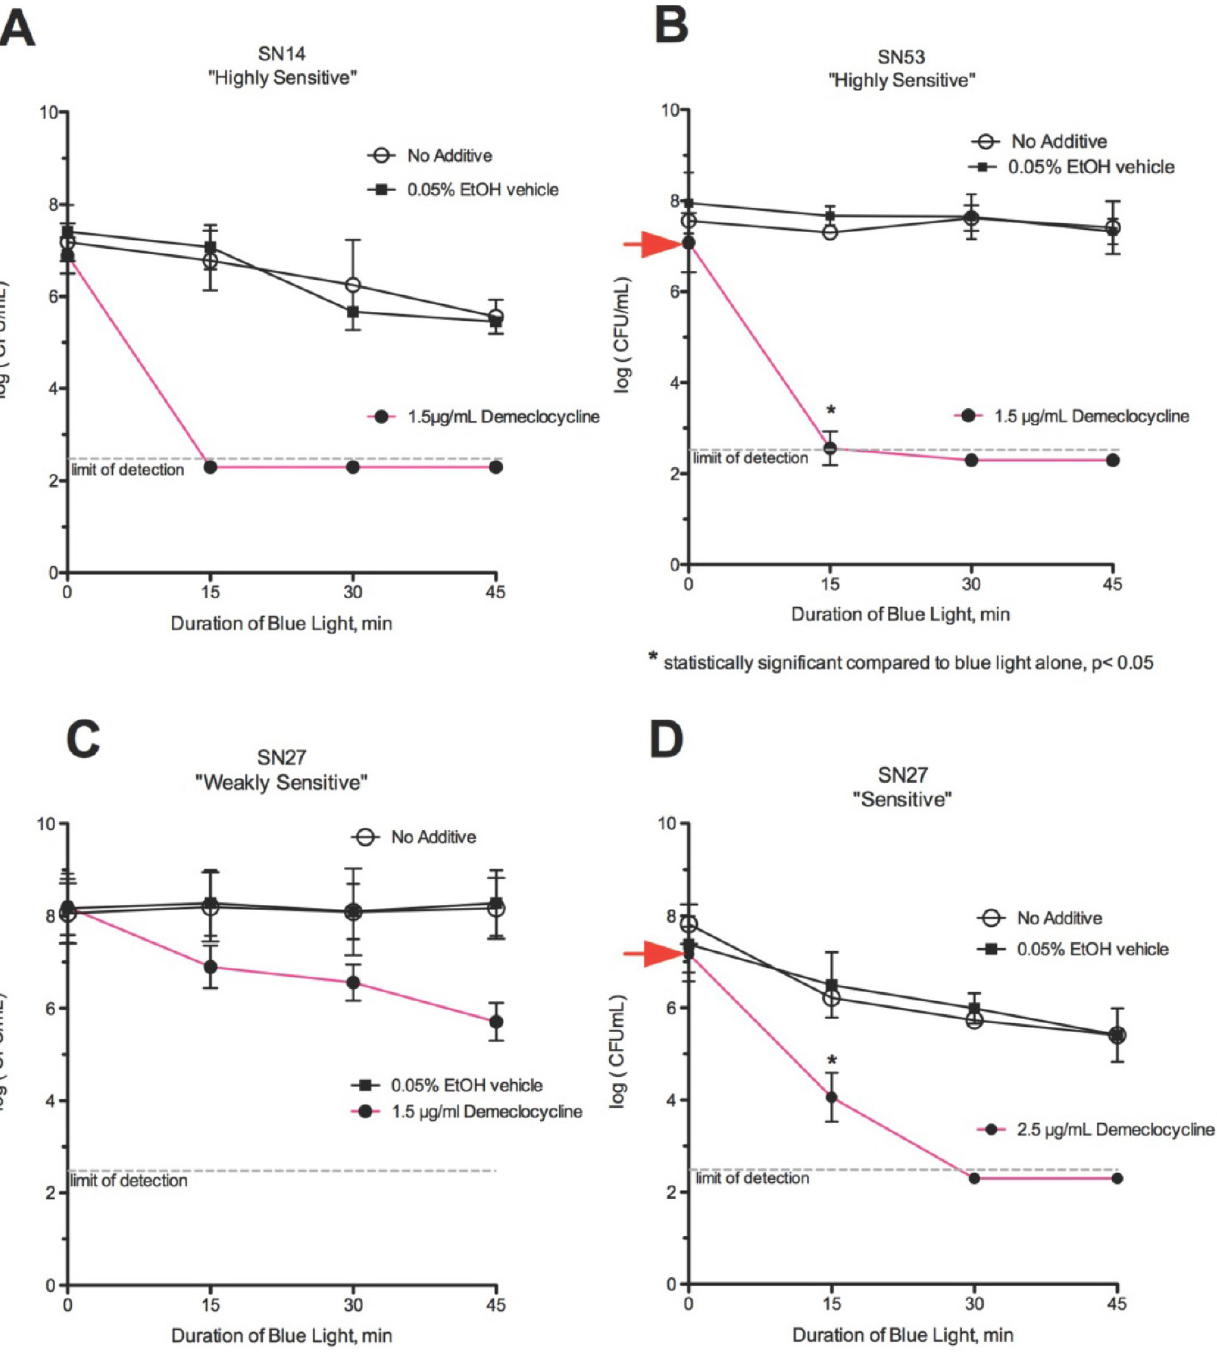
Figure 5. Effect of demeclocycline and blue light. (A) Strains SN14 and (B) SN53 became HS using blue light with demeclocycline. (C) Strain SN27, our most resistant strain, was WS using 1.5 µg/mL of demeclocycline with 45 minutes of blue light exposure. (D) Strain SN27 was S using 2.5 µg/mL of demeclocycline and was completely killed in 30 minutes in combination with blue light. *Statistically significant compared to blue light